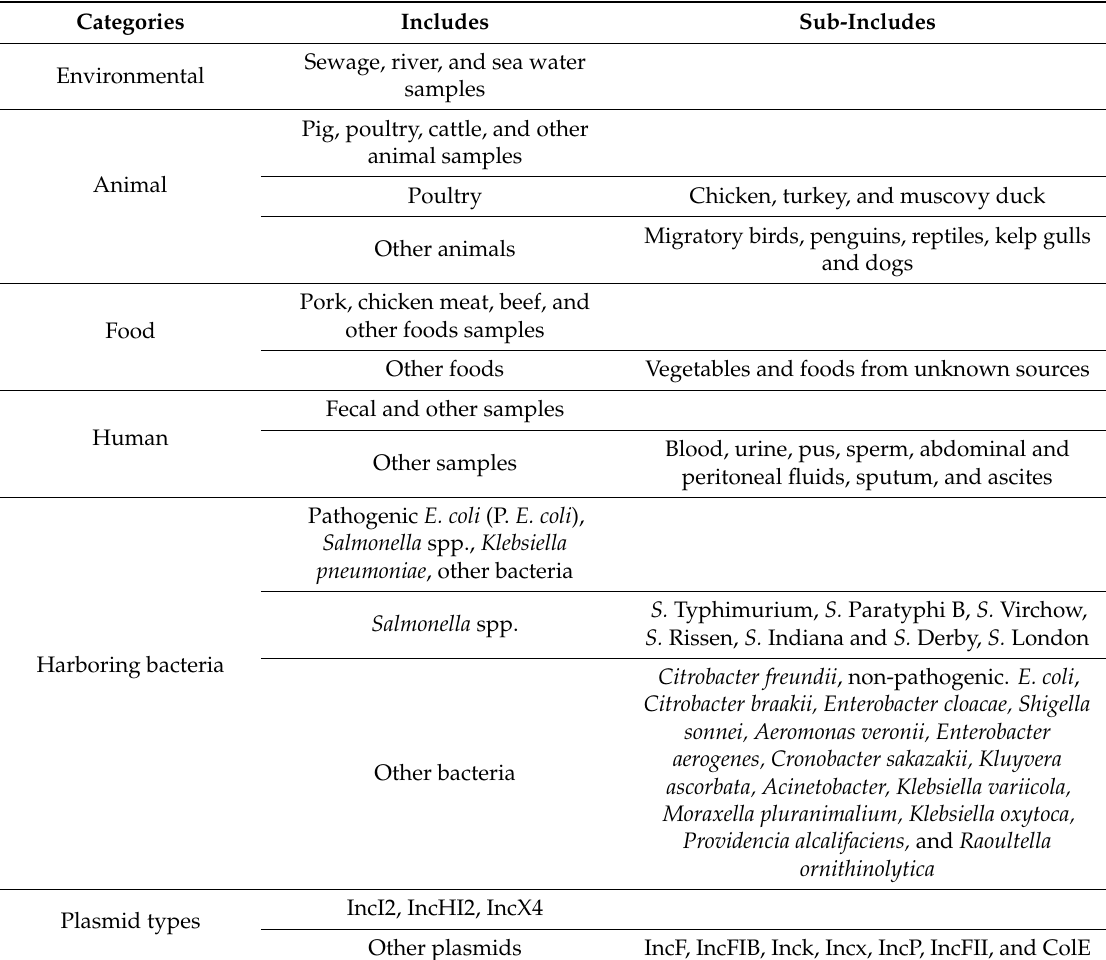
Table 1. Scheme of the data